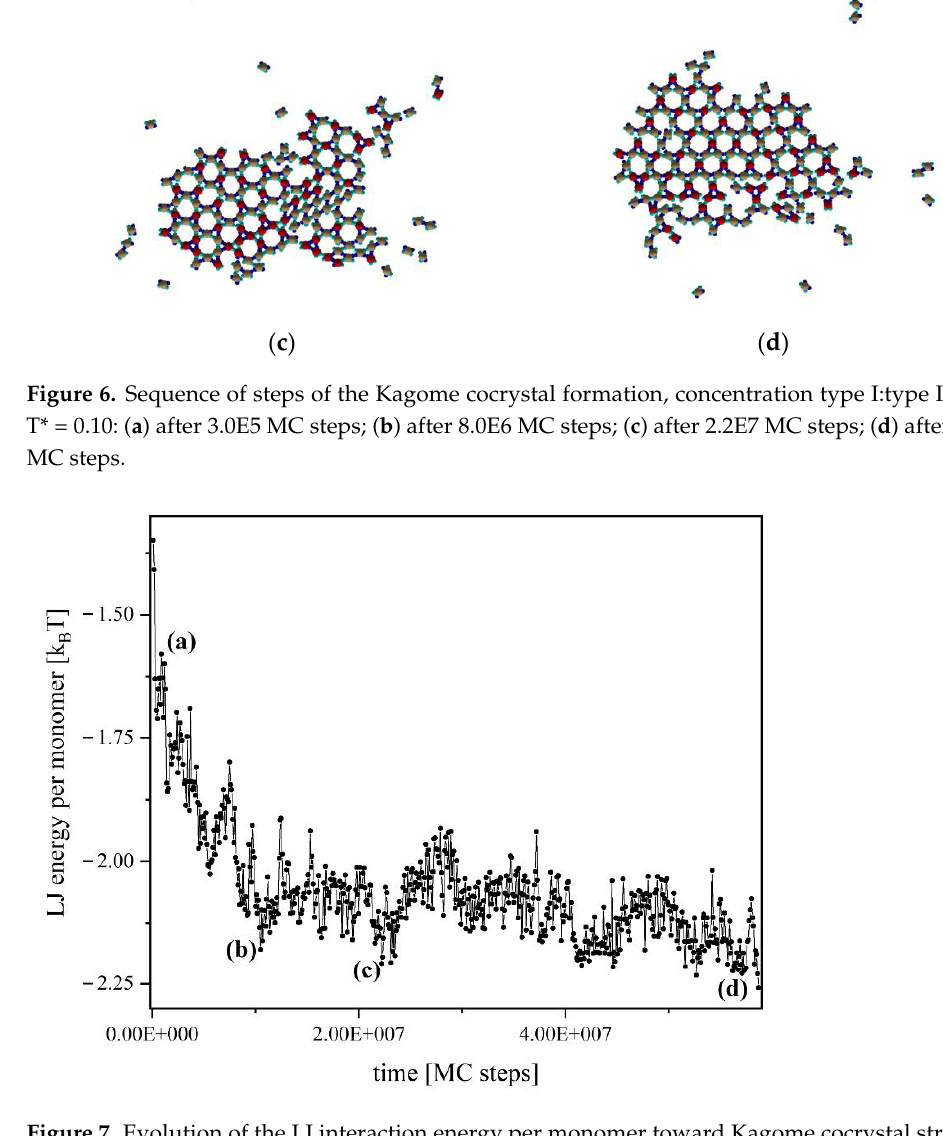
Figure 8. Growth structure from concentration of monomers type I:type II = 1:1, T* = 0.10 after 5.9E7 MC steps – several different domains with rhombohedral and Kagome like placement of the PPs, but without defined periodicity.